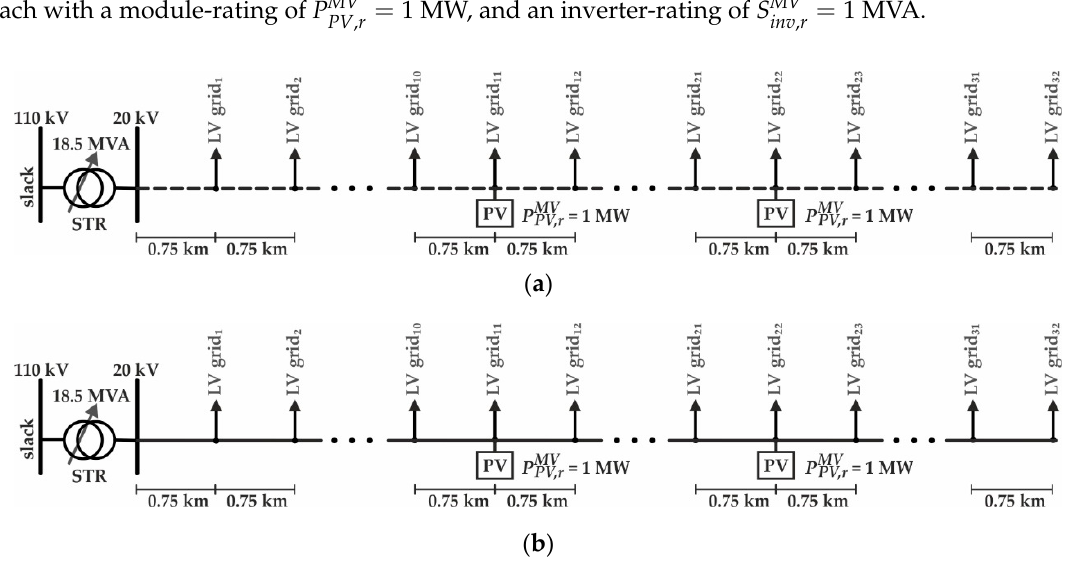
Figure A1. Detailed one-line diagrams of the MV_link-grid models with different conductor types: ( a ) cable; ( b ) overhead line.